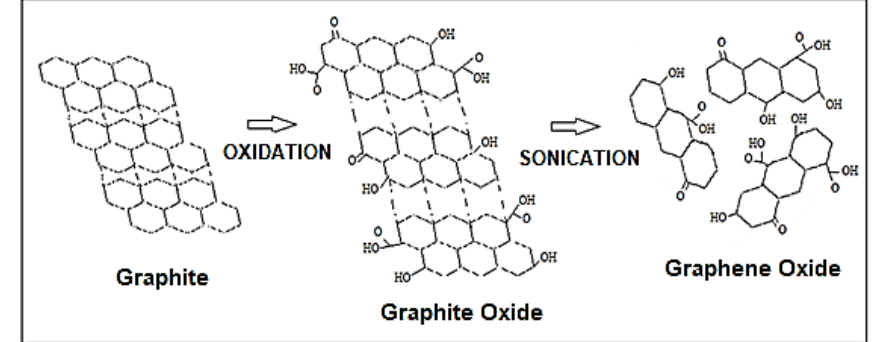
Figure 1. Schematic model of the synthesis to obtain GO by oxidation of graphite.